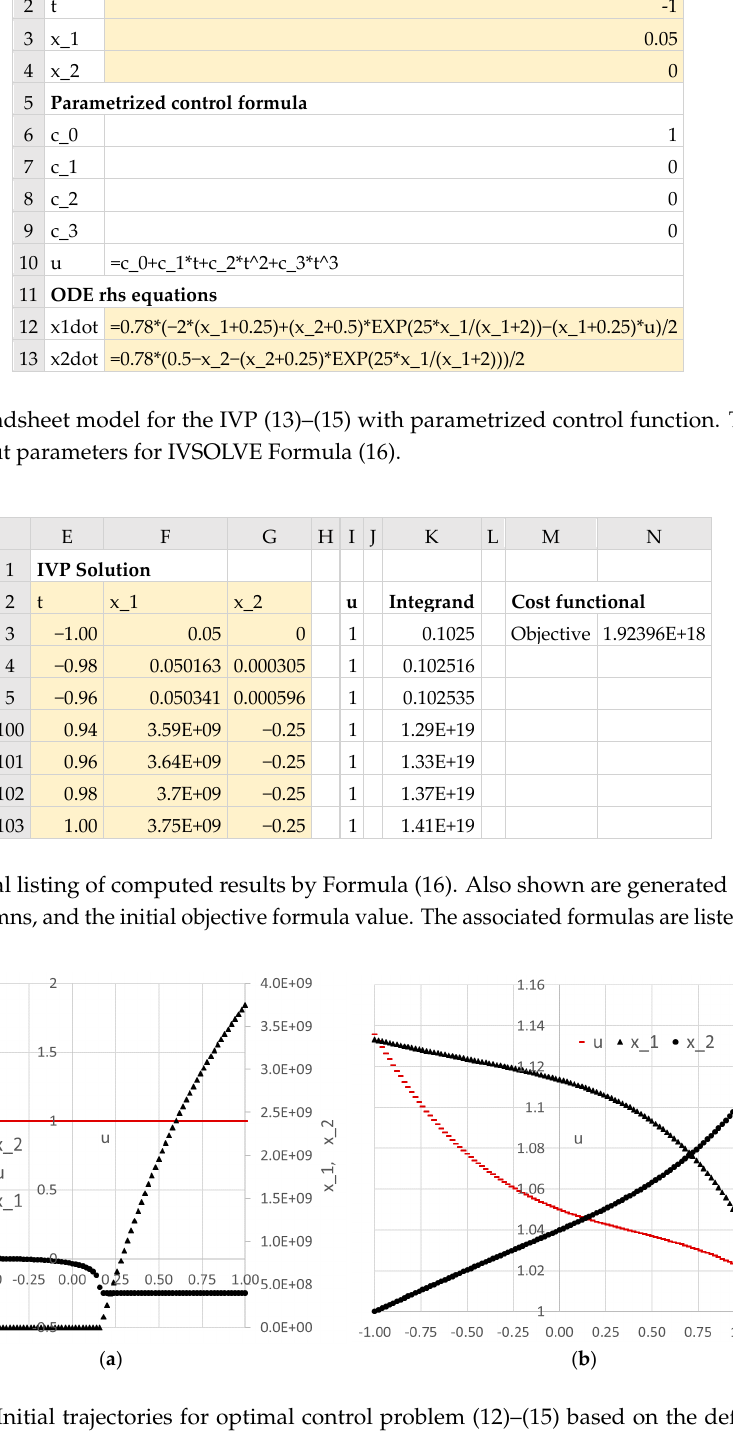
Figure 11. Answer Report generated by Excel’s Solver for optimal control problem (12)–(15) based on the initial guess values in Figure 8. Figure 12. Answer Report for optimal control problem (12)–(15) using a different initial guess and yielding improved minimum.